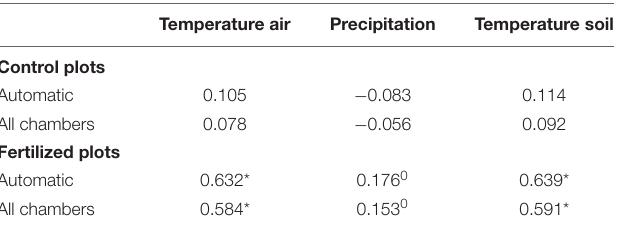
TABLE 1 | Spearman Rank Order Correlation coefficient between N 2 O fluxes and climatic factors: air and soil (20 cm depth) temperatures as well as precipitation for the period with automatic chambers and period including all chamber measurements (manual and